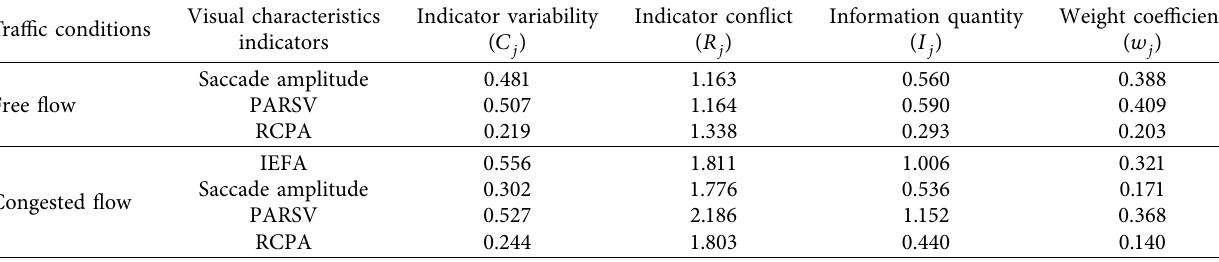
Table 12: Summary of analysis results based on improved CRITIC